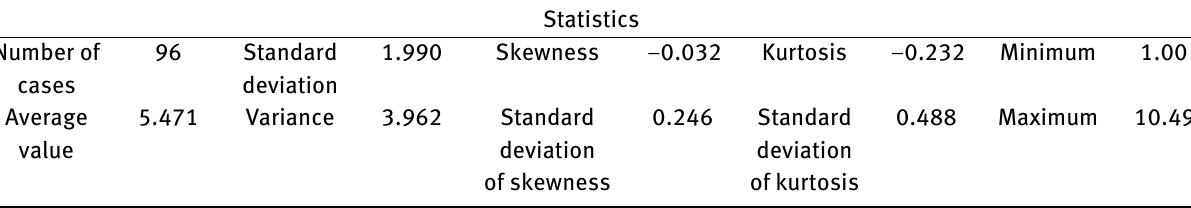
Table 2: Single-sample K-S test results